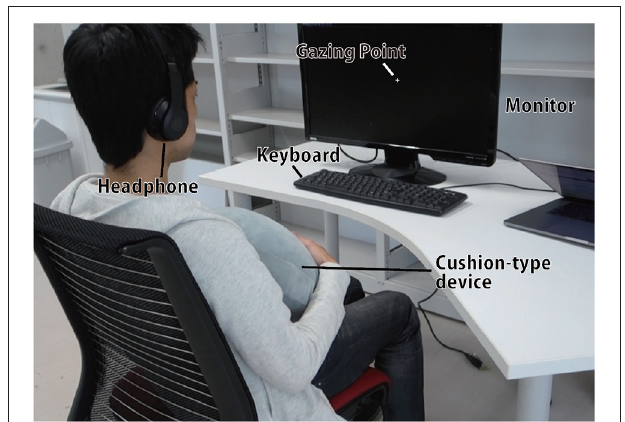
FIGURE 5 | Experimental scene. Other than the desk, monitor, keyboard, and device, all other objects not related to the experiment were hidden from the user’s eyes, and white noise was played from the head phone to suppress background sounds.